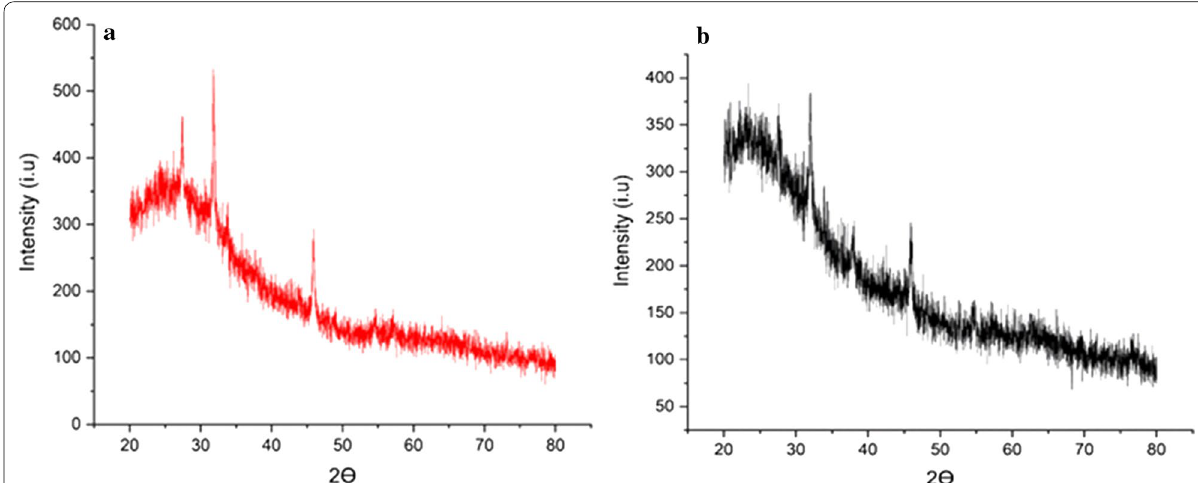
Fig. 3 XRD spectra of a callus extract mediated AgNPs and b ciprofloxacin